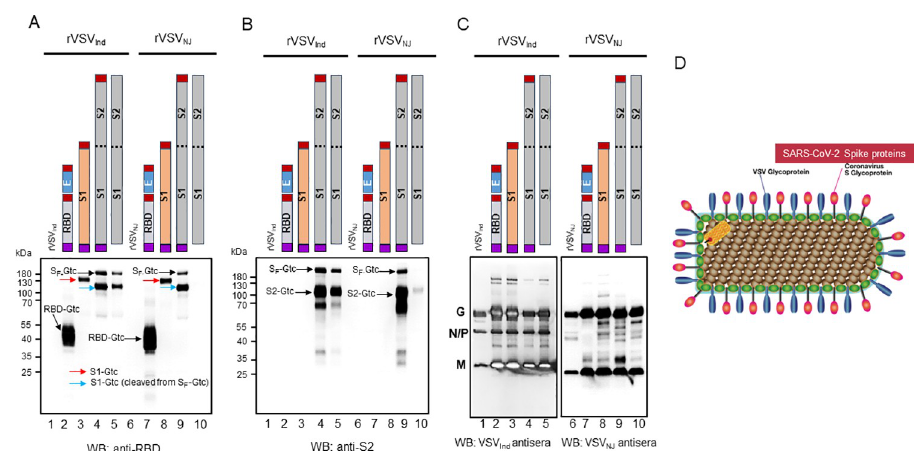
Fig 4. SARS-CoV-2 RBD, S2, and S F with VSV G transmembrane domain and cytoplasmic tail (Gtc) are incorporated efficiently into highly purified rVSV virions. To examine immune responses in mice, it was first necessary to purify rVSV-SARS-CoV-2 viral particles by anion-exchange chromatography. One μ g of the purified rVSV-SARS-CoV-2 was analyzed by SDS-PAGE and the presence of RBD, S1, S2, and S F was determined by Western blot analysis. (A) Detection of RBD, S1, and S F on VSV particles. (B) Detection of S2 and S F on VSV particles. (C) Detection of VSV Ind and VSV NJ proteins. (D) Depicted model of pseudotype recombinant VSV virions with three different forms of SARS-CoV-2 Spike proteins. rVSV pseudotypes are formed when rVSV-SARS-CoV-2 Spike proteins are expressed with the msp at the NH 2 -terminus and VSV Gtc at the COOH-terminus. Purple box: honeybee msp, red box: VSV Gtc. both VSV G and SARS-CoV-2 S glycoproteins (Figs 4D and S4). Thus, purified rVSV-SARS- CoV-2-msp-S -Gtc vaccine virus carries spike proteins of SARS-CoV-2. As expected, msp and F Gtc modified S or S1 protein had higher virion incorporation into the rVSV pseudotypes F when compared to the non-modified forms. This difference was particularly apparent for rVSV vaccines where the non-modified S had no detectable incorporation of S or S1, and NJ F F barely detectable S2. Similar quantities of VSV G and M proteins were observed between the different rVSV SARS-CoV-2 vaccine constructs. The results demonstrated that purified rVSV-SARS-CoV-2 carry sufficient RBD, S1, S2, and S proteins to induce immunity. The rel- F ative amount of infectious rVSV-SARS-CoV-2-msp-S -Gtc vectors harboring gRNA was F between 1 and 2% (S1 Table) as an estimate of total virus particle count. All VSV particles con- tain VSV gRNA based on process of rhabdovirus assembly. The ratio of infectious to total virus particles for wild type VSV is estimated to be 1 to 5%, which is similar to that observed with our VSV vaccine vectors [30–32]. Recent studies suggest that aggregation of infectious VSV particles can lead to co-infection of a cell resulting in a single plaque, often reducing the ratio of infectious to non-infectious particles [33,34]. It is important to stress that all infectious, defective-interfering, or non-infectious VSV vectors found as single particle or as an aggregate, will express the SARS-CoV-2 spike protein (S4 Fig) and are immunogenic (see below).